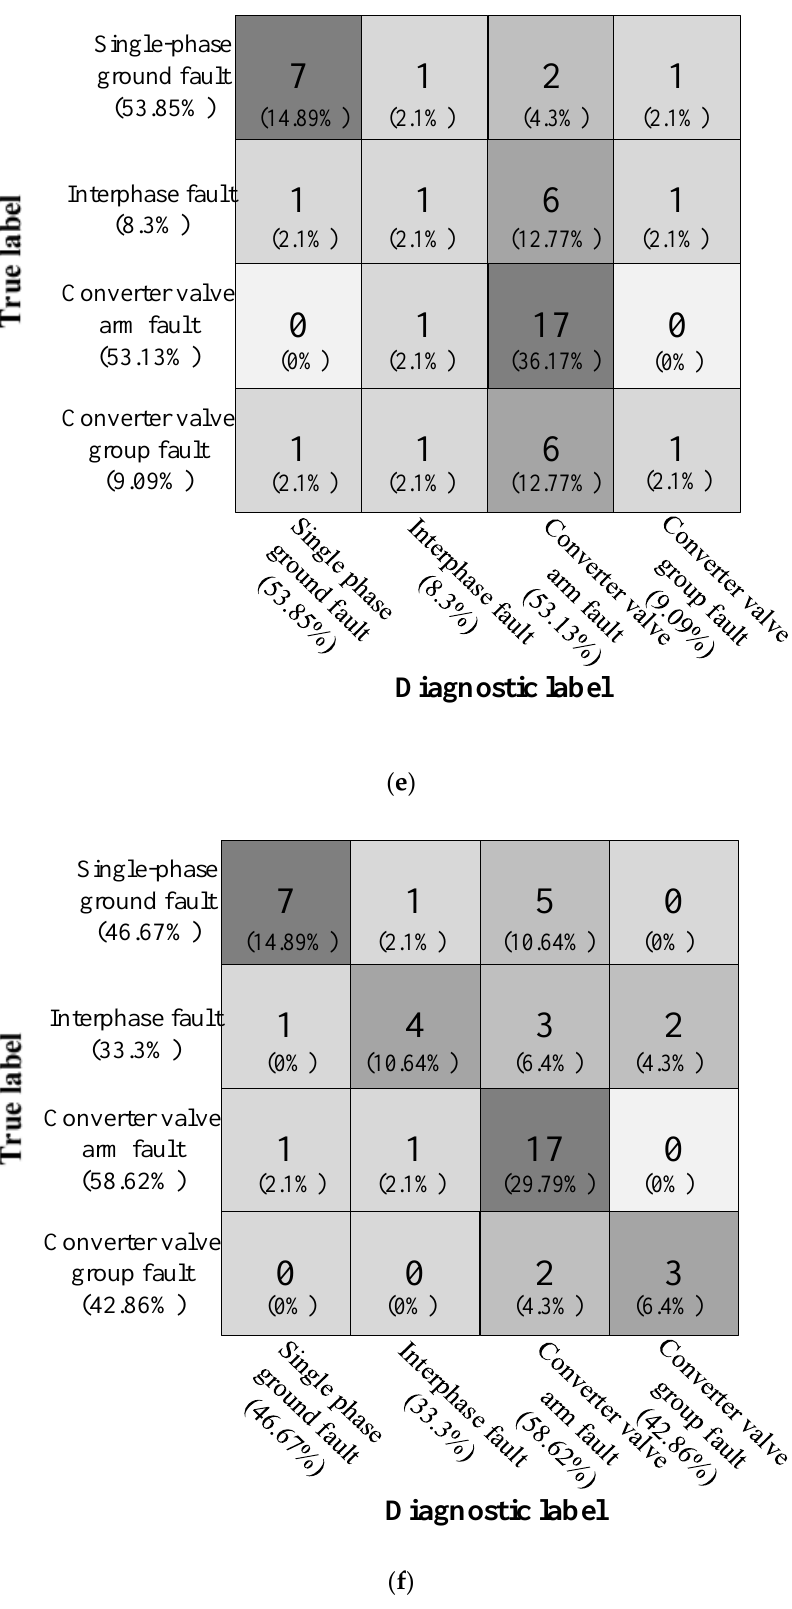
Figure 7. Test result confusion matrices of three methods: ( a ) XGBoost model test results, ( b ) BP neural network model test results, ( c ) PNN model test results, ( d ) Classification learner, ( e ) SVM, and ( f ) KNN.